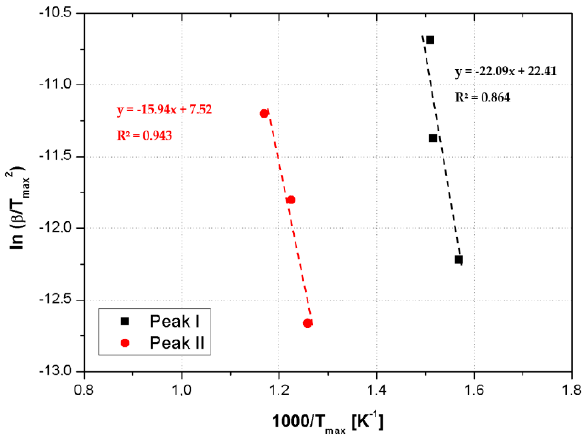
Table 3. Kissinger activation energies for each of the degradation steps for the CSNPs/RTM6 systems in air.